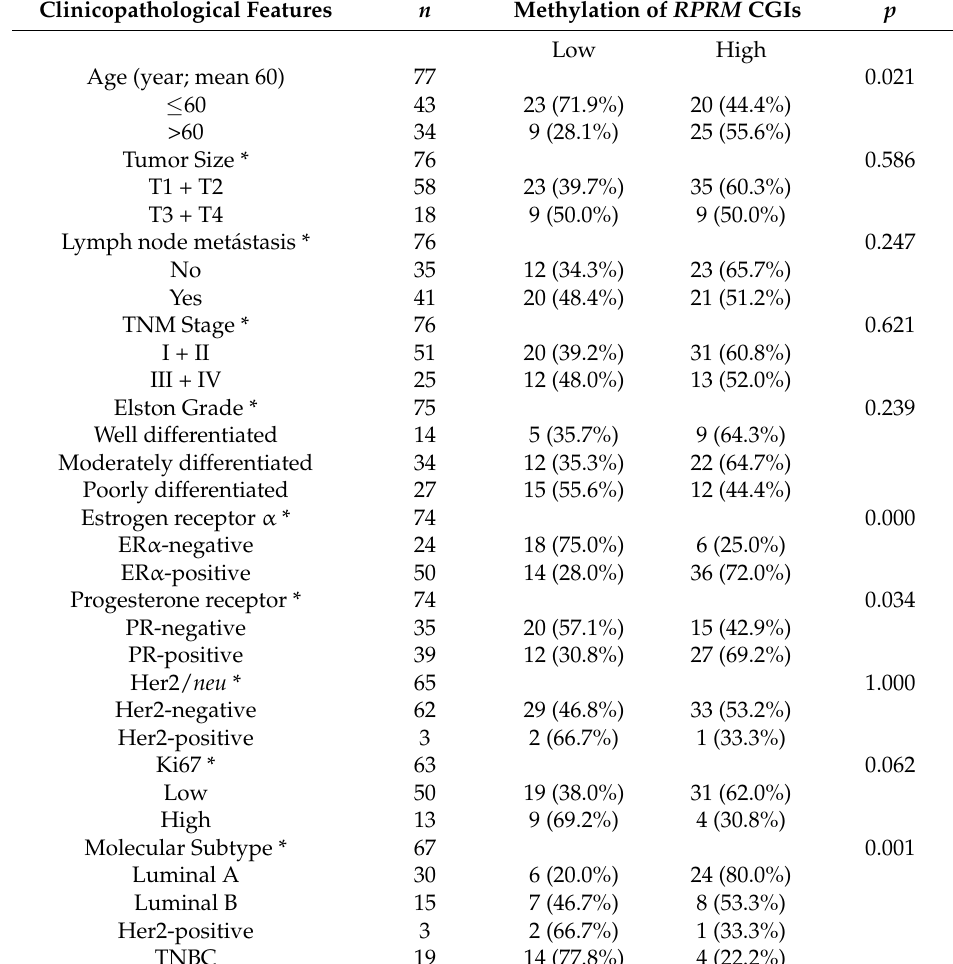
Table 1. Association between RPRM methylation of CGIs and clinicopathological